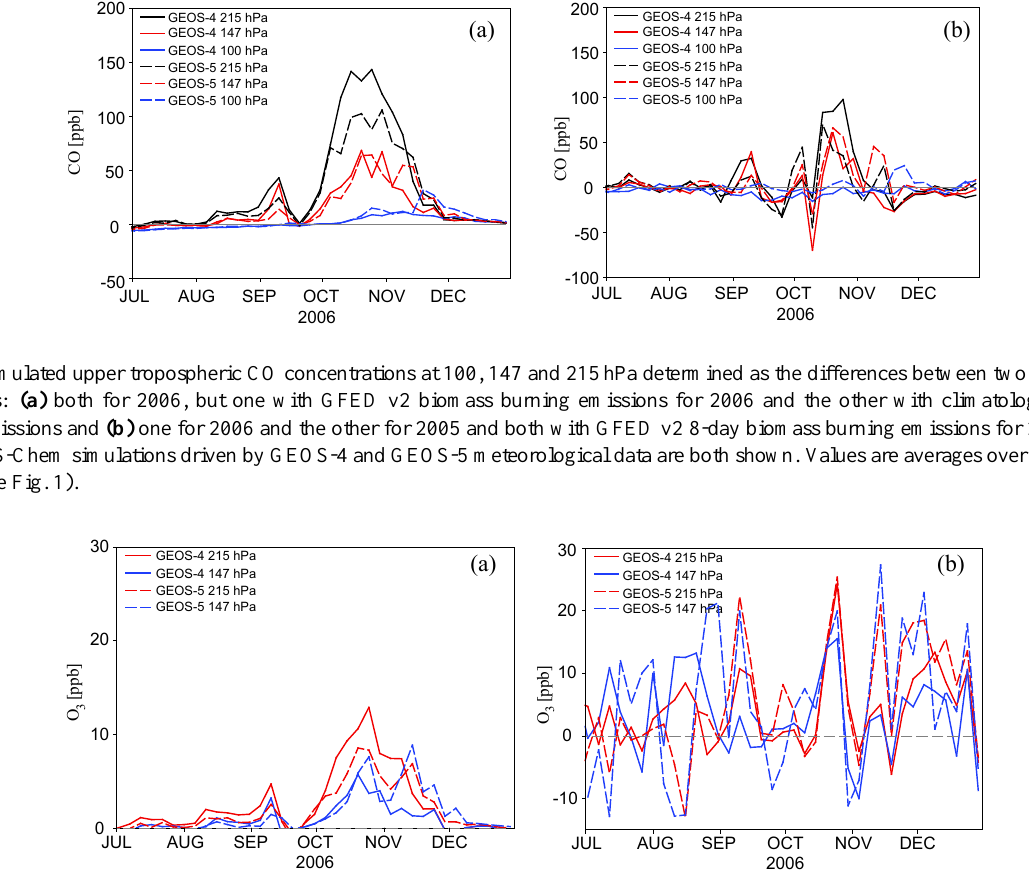
Fig. 12. Same as Fig. 10, but for O 3 at 215 and